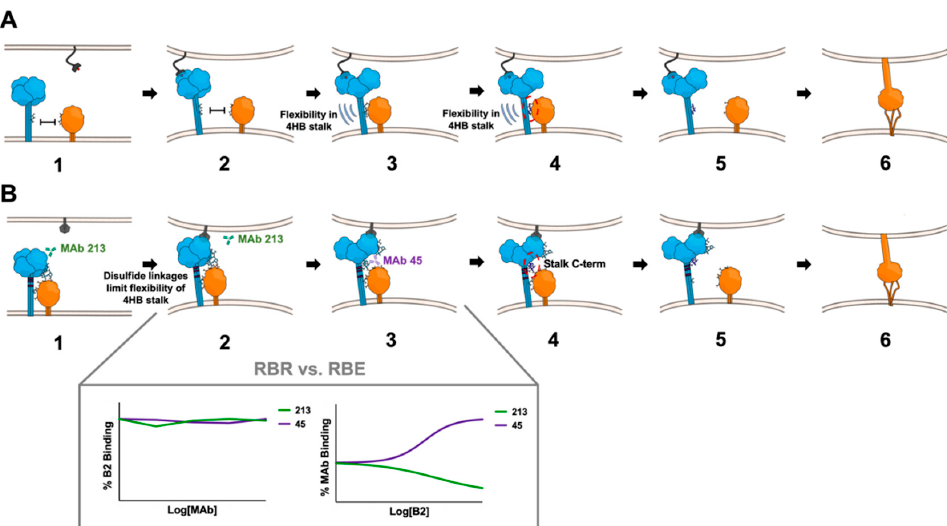
Figure 7. Models of the F activation pathways for SA- vs. B2-using PMVs. The PMV RBP (blue) and PMV F (orange) proteins are shown. Blue and orange sticks denote hypothesized regions of interacting residues but are not meant to represent specific amino acids. ( A ) Proposed model for SA-using PMVs. Prior to receptor binding, the HN tetramers and F trimers do not hetero-oligomerize because of the four “heads down” conformation ( Panel 1 ). HN binds to sialic acid present on glycoproteins or glycolipids ( Panel 2 ). Receptor binding leads to structural transition of the head domains to a “heads up” conformation, enabling F trimers to contact HN. The flexibility of the noncovalently-associated 4HB stalk facilitates the “heads up” transition, and stalk refolding exposes residues important for F interaction and triggering ( Panel 3 ). The post-receptor-binding trigger-competent central stalk region sends a destabilization signal (dark blue residues, circled in red) to F ( Panel 4 ). Relaying of the signal results in F and HN dissociation ( Panel 5 ) and destabilization of the F trimers to form the pre-hairpin intermediate (PHI) ( Panel 6 ). ( B ) Proposed model for B2-using PMVs. The G tetramers and F trimers associate via the globular head and 4HB stalk prior to receptor binding, i.e., a bidentate interaction. Conformational MAb 213 binds proximal to the B2 receptor binding site ( Panel 1 ). Binding of the B2 receptor reduces MAb 213 binding—RBR ( Panel 2 ). Receptor binding causes the tetrameric heads to transition to the “heads up” conformation, exposing a proline-rich subdomain in the very C-terminal stalk. This conformational change also increases exposure of the MAb 45 epitope at the base of the globular head enhancing MAb 45 binding—RBE ( Panel 3 ). Inset contains representative data from Liu et al. (2013) to illustrate these receptor-induced behaviors: left, neither MAb 213 nor MAb 45 compete with receptor ephrin-B2 binding on NiV-G; right, following receptor ephrin-B2 binding, MAb 45 exhibits enhanced binding to NiV-G, whereas MAb 213 exhibits reduced binding. This revealed proline-rich subdomain at the stalk C-terminal region signals F to trigger (dark blue residues, circled in red) ( Panel 4 ). The preassembled hetero-oligomeric F / G complexes dissociate ( Panel 5 ) and the free, destabilized F transitions to the prehairpin structural intermediate (PHI) ( Panel 6 ). The CD150 / Nectin-4-using RBP model is not shown here to avoid redundancy, as it behaves as a hybrid of the two F activation pathways, i.e., follows the dissociation model, but the F-interacting and -activating regions are located centrally in the 4HB stalk. Figure schema courtesy of Gri ffi n